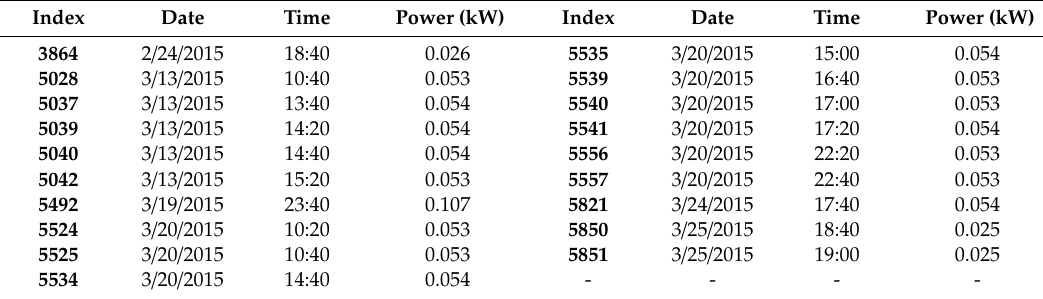
Table 1. 20-min power samples lower than 0.12